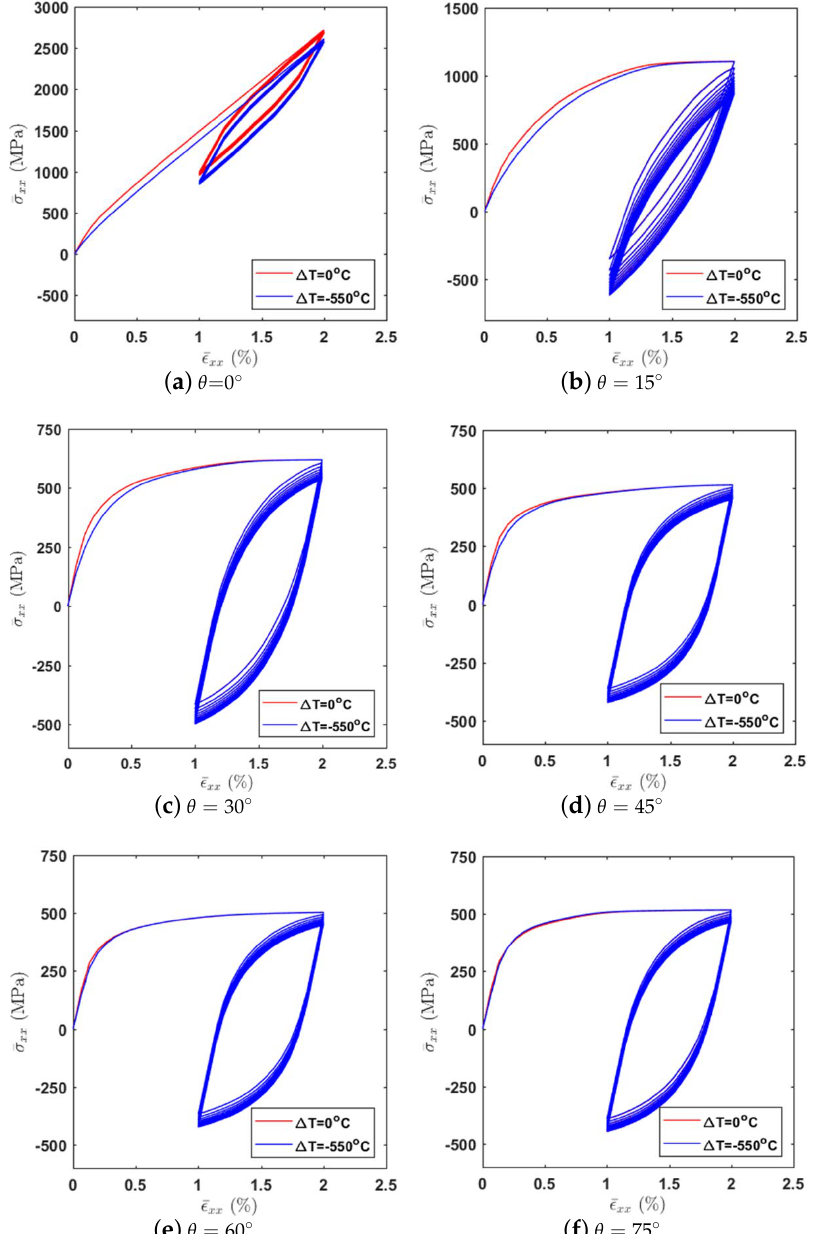
Figure 11. The cyclic stress–strain response with consideration of the thermal effect for the composite materials with different fiber